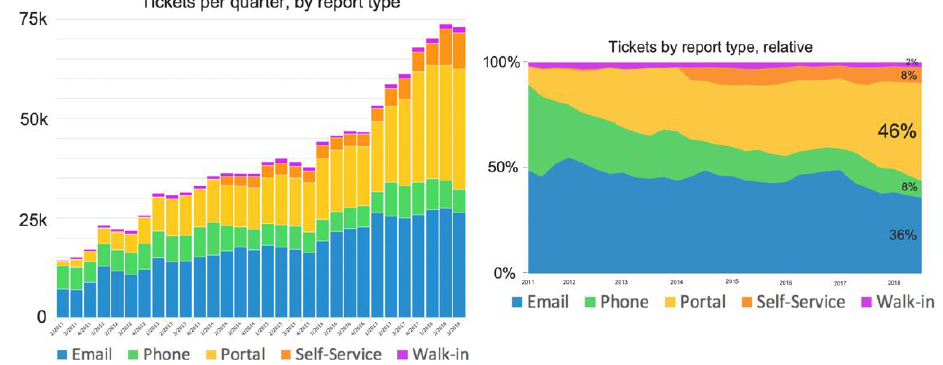
Fig. 3. Evolution of tickets at CERN by report type. Percentages on the right correspond to Q3